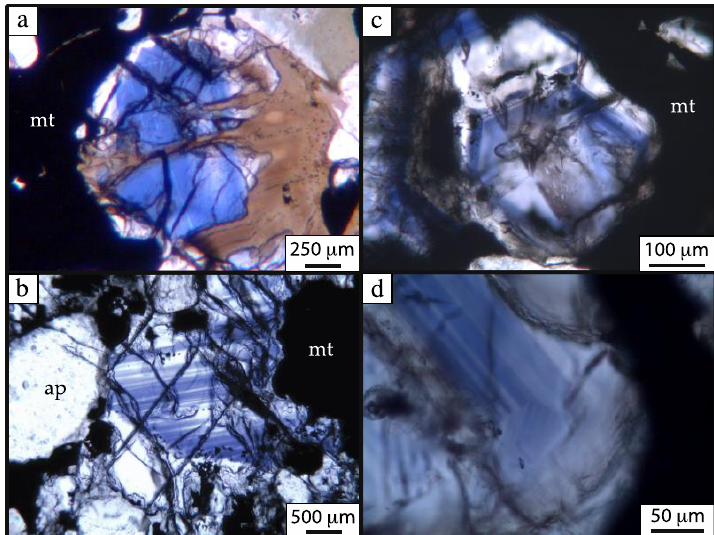
Figure 4. Photomicrographs of blue sapphire in plane-polarized light surrounded by magnetite (mt) and apatite (ap). ( a ) Fractured grain with deep-blue color, replaced by a fine-grained mixture of retrograde chlorite and biotite (brown), ( b ) sapphire showing typical rhombohedral parting and oscillatory zoning between blue and clear sections, ( c ) sapphire viewed perpendicular to (0001), showing typical clear and strongly blue colored hexagonal zoning, ( d ) sapphire showing fine oscillatory zoning. Note, jagged growth sector boundary between the upper and lower zoned halves (see text for discussion).